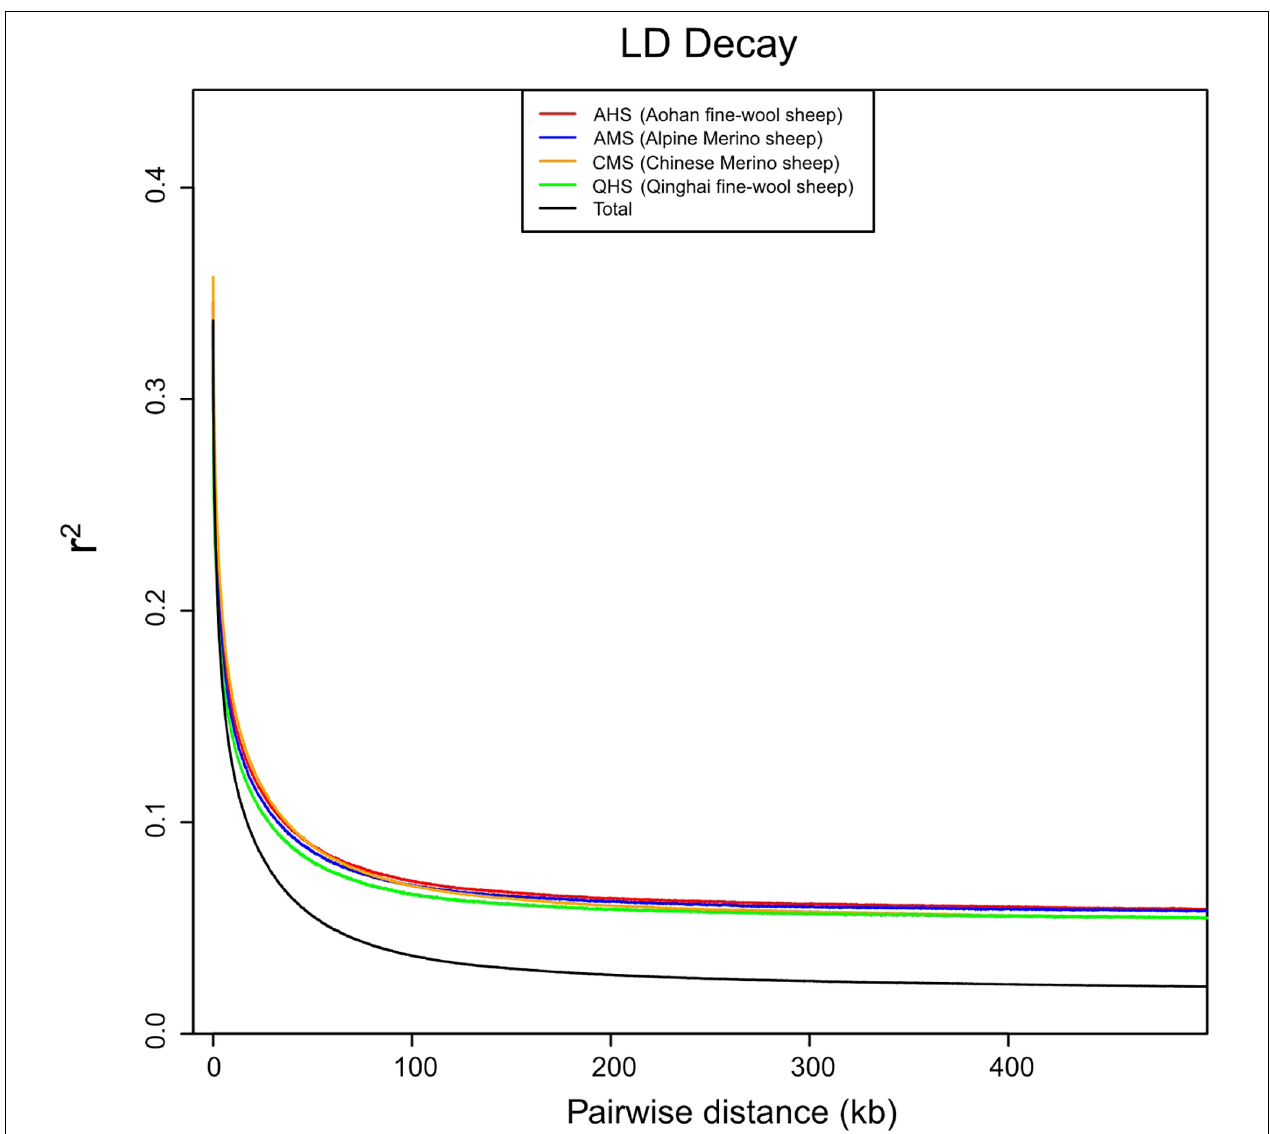
FIGURE 2 | Population selective analysis of linkage disequilibrium (LD) decay. The LD decay rate was measured as the distance at which the average squared correlations of allele frequencies ( r 2 ) dropped to half its maximum value.